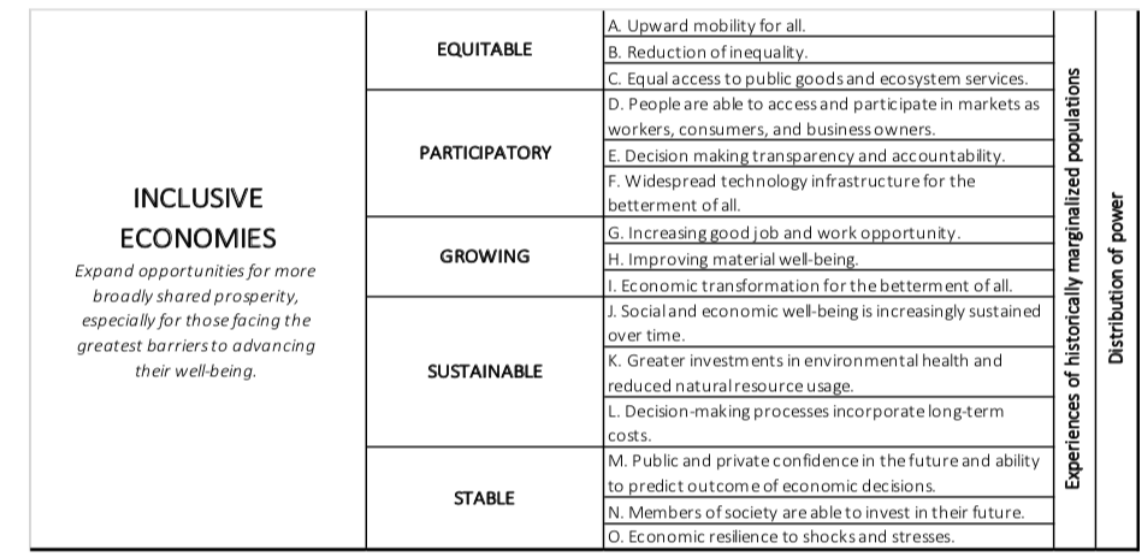
Figure 1: Framework for more inclusive economies